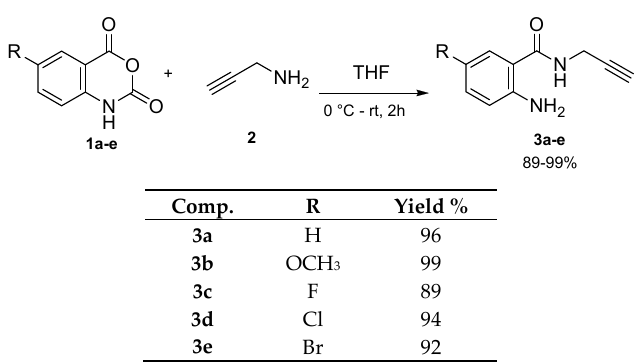
Figure 4. Ligand-based design of novel PqsA inhibitors.